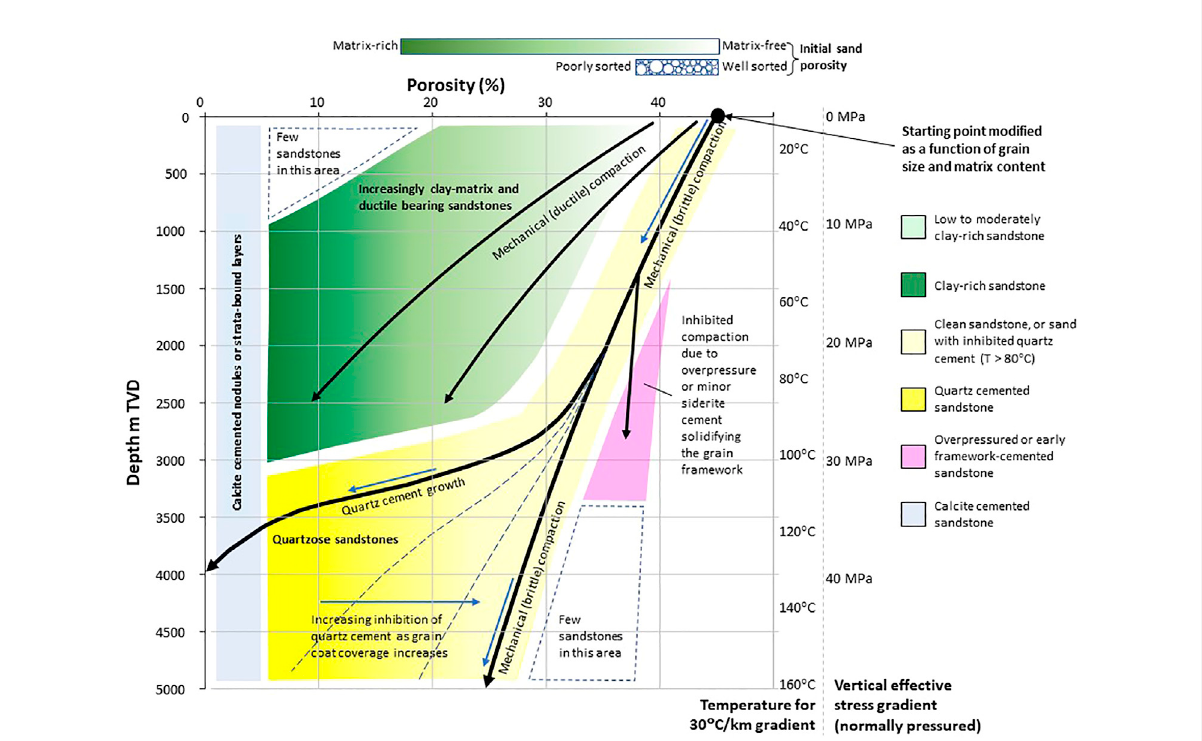
FIGURE 1 Porosity versus depth diagram for sandstones, with a second Y -axis representing temperature for a steady 30 ° C/km geothermal gradient and a surfacetemperatureof10 ° C,plusathird Y -axisrepresentingeffectivestressfornormallypressuredporousrocks.Porosityatthetimeofdepositionis a function of sorting and matrix content, with clean, randomly-packed sands having up to about 42% – 48% porosity. Poorer sorting leads to lower porosity; more matrix leads to lower porosity. Burial of clean sandstones with few ductile grains or matrix (pale yellow area) reduces porosity to about26%duetograinrearrangementandtheadoptionofarhombohedrallyclose-packedfabric.Sandsrichinweak,ductilegrainsormatrix(green area) loseporositymore quickly with increasingdepth than sandscomposedofstronggrains. Sands with calcite cementtend toacquirethecement soon after deposition and have very low porosity (blue area). Clean sands undergo chemical compaction and quartz cementation once the temperature exceeds about 80 ° C (bright yellow area). Quartz cement can be inhibited by chlorite-, microquartz- and siderite-grain coats and possibly by early oil emplacement and early overpressure leading to anomalously high porosity deep in sedimentary basins. Early overpressure and the growth a small amounts of framework stabilising cement, such as siderite, inhibit compaction and lead to anomalously high porosity at intermediate depths in sedimentary